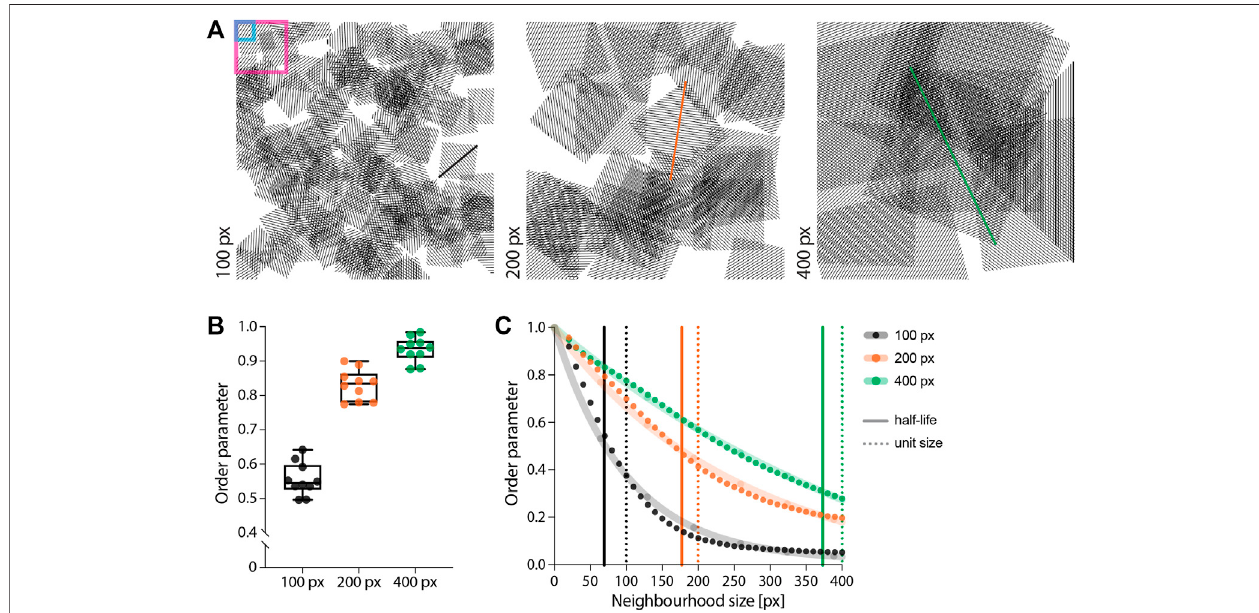
FIGURE 5 | Evaluating length scale on synthetic data. (A) Synthetic images were created by randomly distributing units of parallel lines within the fi eld of view. The sizeofeachunitwaspre-de fi nedtobeeither100 px (left,black),200 px (centre,orange)or400 px (right,green).Eachsamplecontains10images.Theblueandmagenta boxes represent the window and neighborhood sizes used for the analysis in (B) , set to 35 px and 100 px , respectively. (B) Measuring the order parameter using the same parameters for the three sets of images shows an increase in its median value with the unit size. This can be expected, as the information within this length scale will be more aligned the bigger the unit size. (C) Keeping the window size constant (10 px ) and progressively increasing the neighborhood shows a decay in the order parameter for all three samples (dots). By fi tting a one-phase decay to each data set (shaded lines) and measuring its half-life, it is possible to appreciate how the algorithm is able to locate the pre-de fi ned length scale (i.e., unit